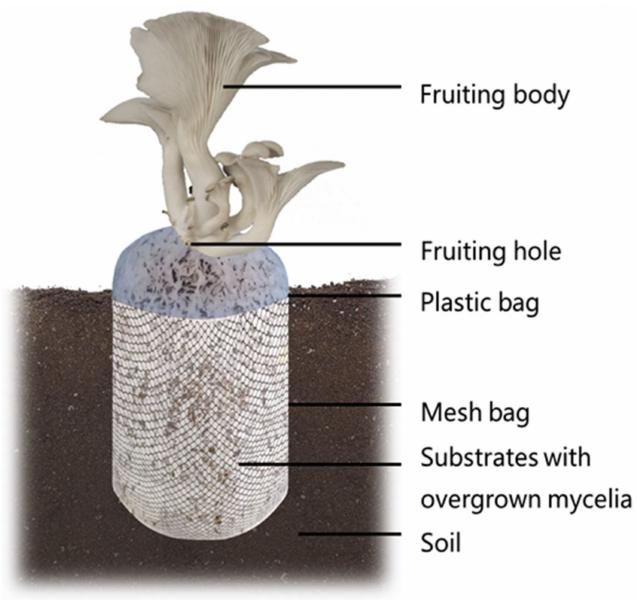
Figure 1. A schematic diagram of the mycoextraction system designed in this